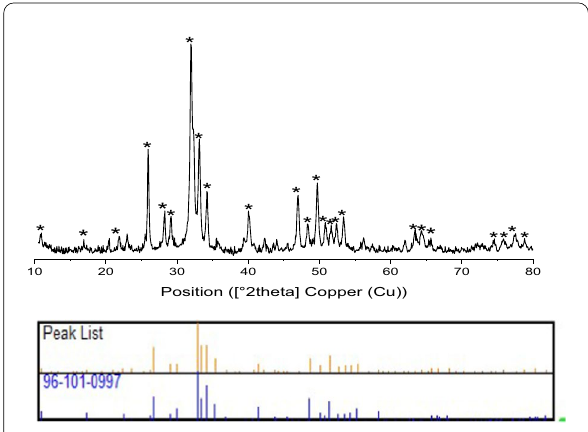
Fig. 1 X-ray diffraction patterns of